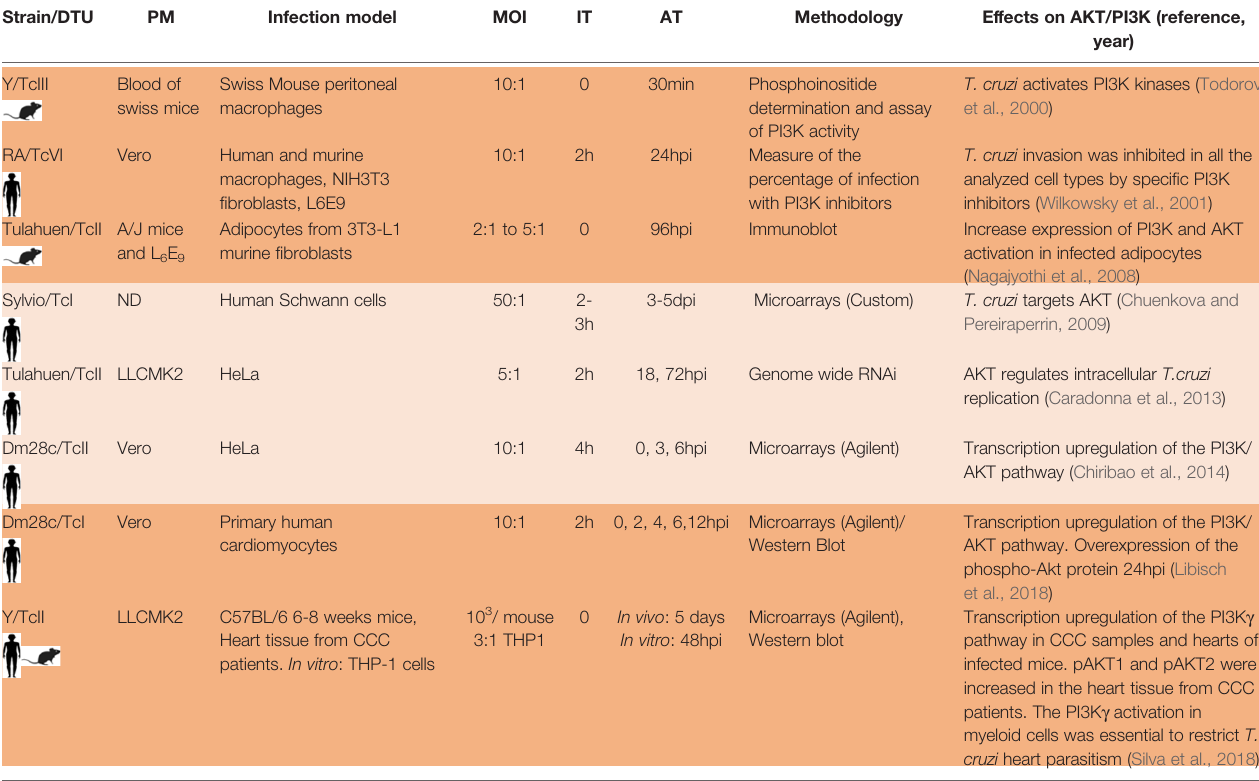
TABLE 3 | Studies related to the host AKT/PI3K response to T. cruzi infection. Strain/DTU